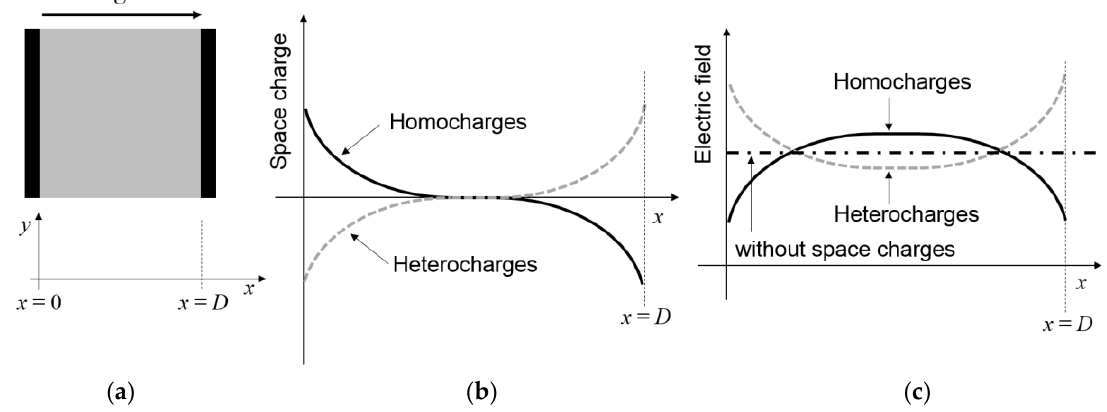
Figure 3. ( a ) Insulation material with thickness D between two planar electrodes with applied voltage U ; ( b ) schematic homocharge and heterocharge distribution; ( c ) effect of the charge distribution on the resulting electric field [2,8].